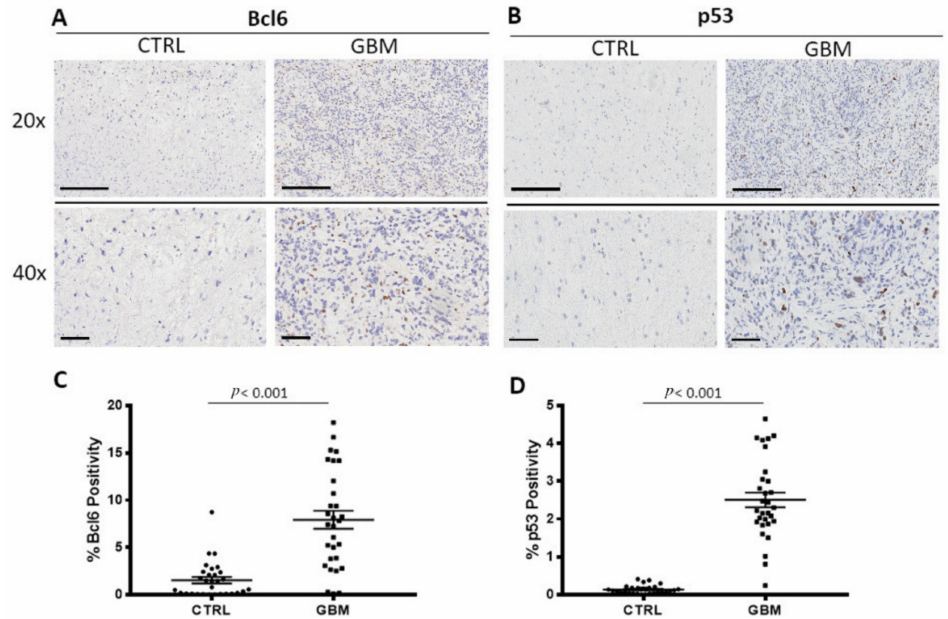
Figure 6. Immunohistochemical staining for Bcl6 ( A ) and p53 ( B ) in both the center of tumor (GBM) and in the healthy surrounding areas (CTRL). Scale bar: 60 µ m (40 × ), 200 µ m (20 × ) ( A ). Morphometric analysis indicating the percentage of BCL6 ( C ) and p53 ( D ) positivity in GBM and CTRL samples.